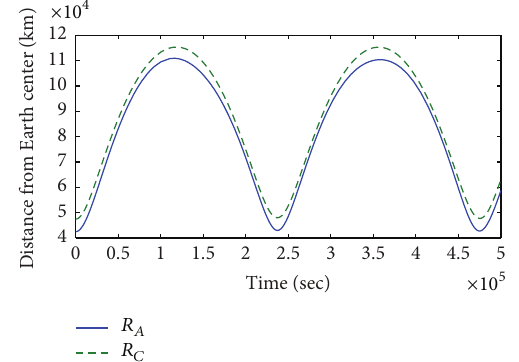
Figure 8: The distances from Earth center as function of time for a prescribed function 𝐿 1 (𝑡) .